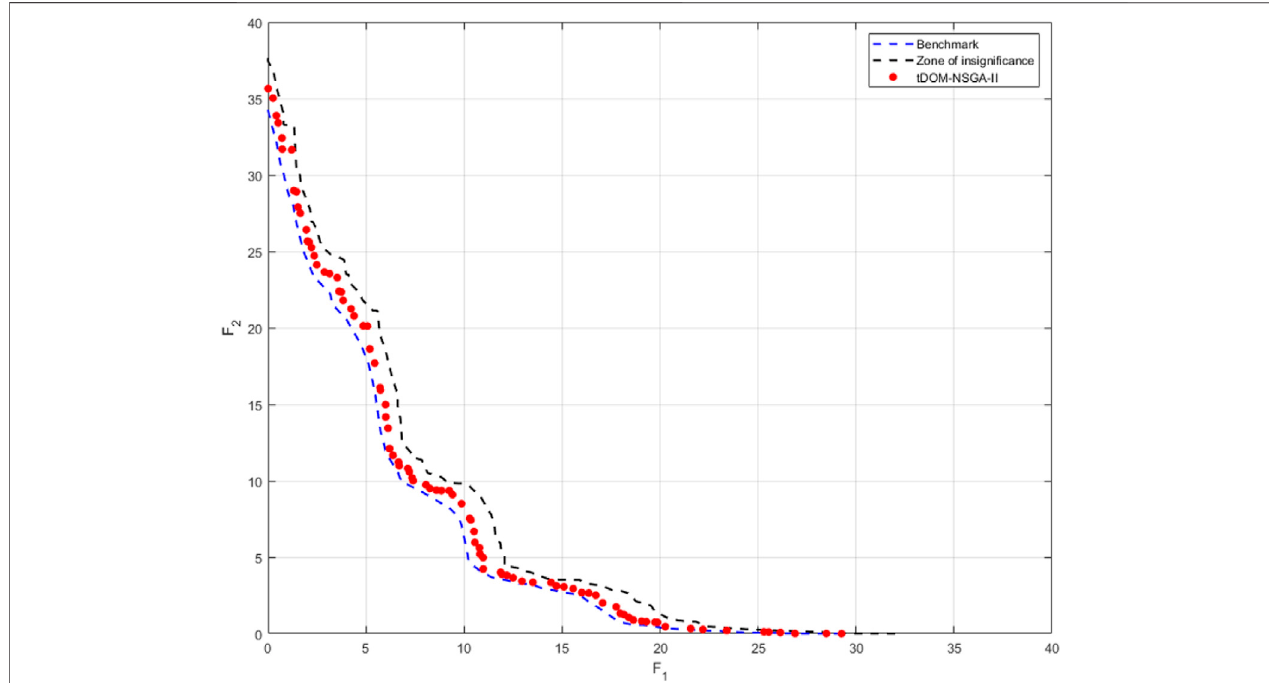
Frontiers in Chemical Engineering |